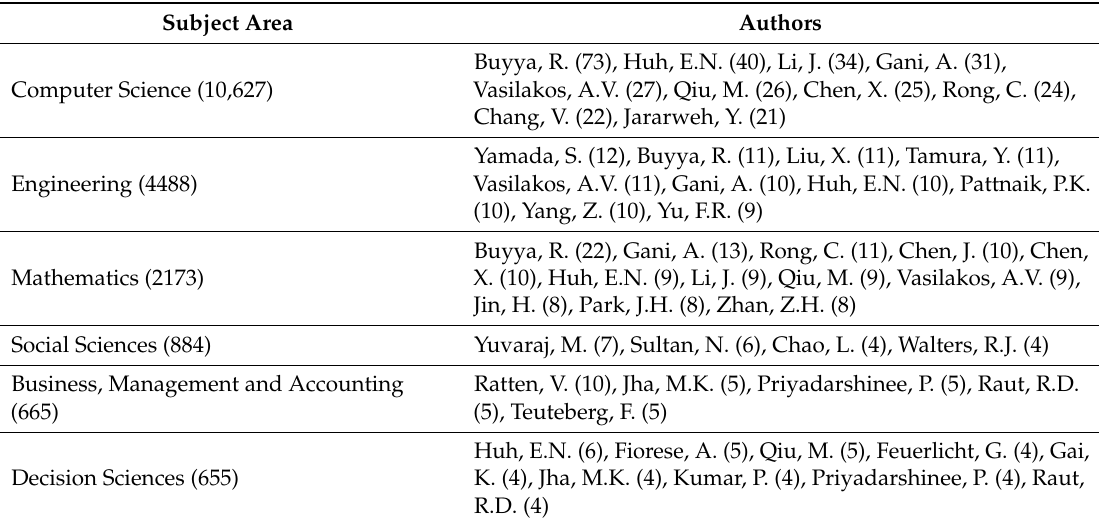
Table 6. Top most productive authors in research on cloud computing by a subject